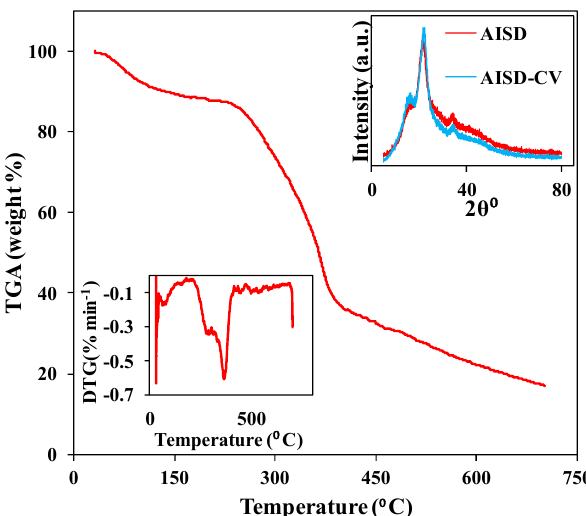
Figure 4. TGA plot of AISD (upper inset − XRD pattern, and lower inset − DTG plot).